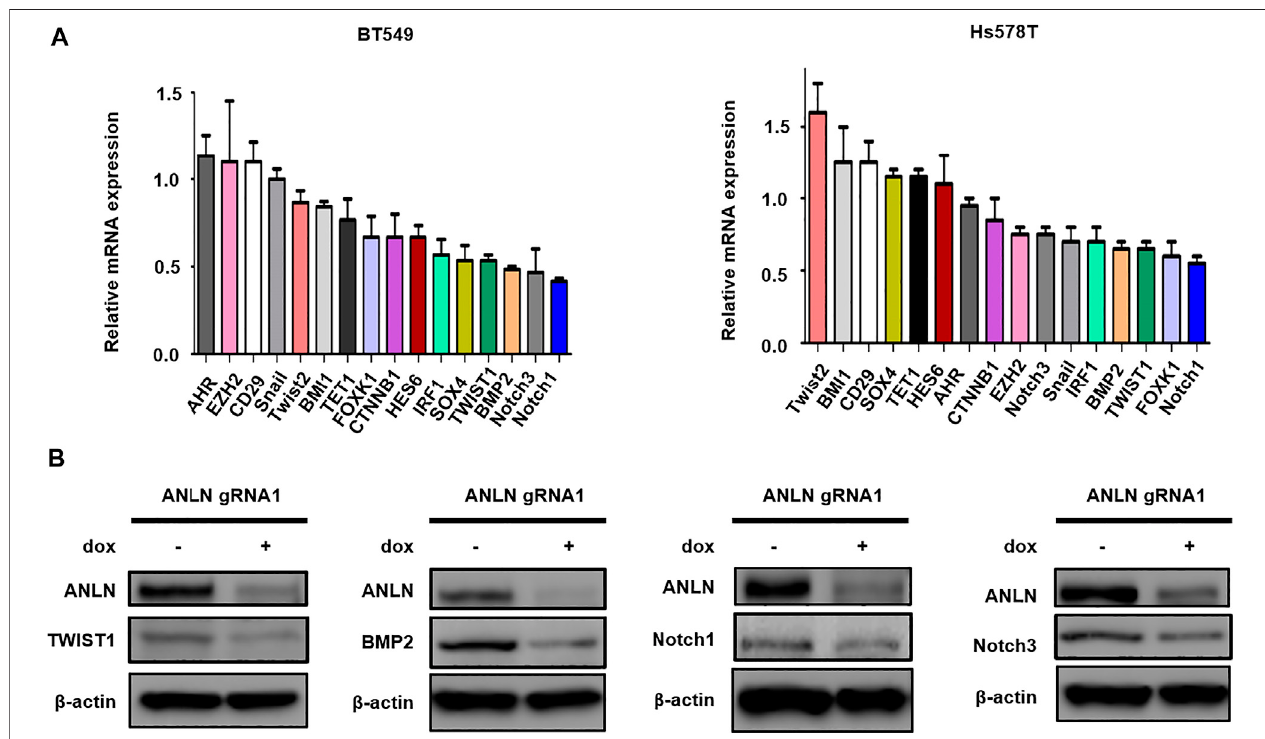
FIGURE 3 | Effect of ANLN on the expression of stemness-related genes. (A) Bar graphs depicting mRNA expression of stemness-related genes in dox-treated (ANLN-knockout) mammospheres compared to mammospheres without dox treatment. Error bars, mean ± SEM of 3 independent experiments. (B) Immunoblot showing expression level of Twsit1, Bmp2, Notch1 and Notch3 proteins in Hs578T cells with and without ANLN knockout. Experiments were repeated twice independently with similar results.